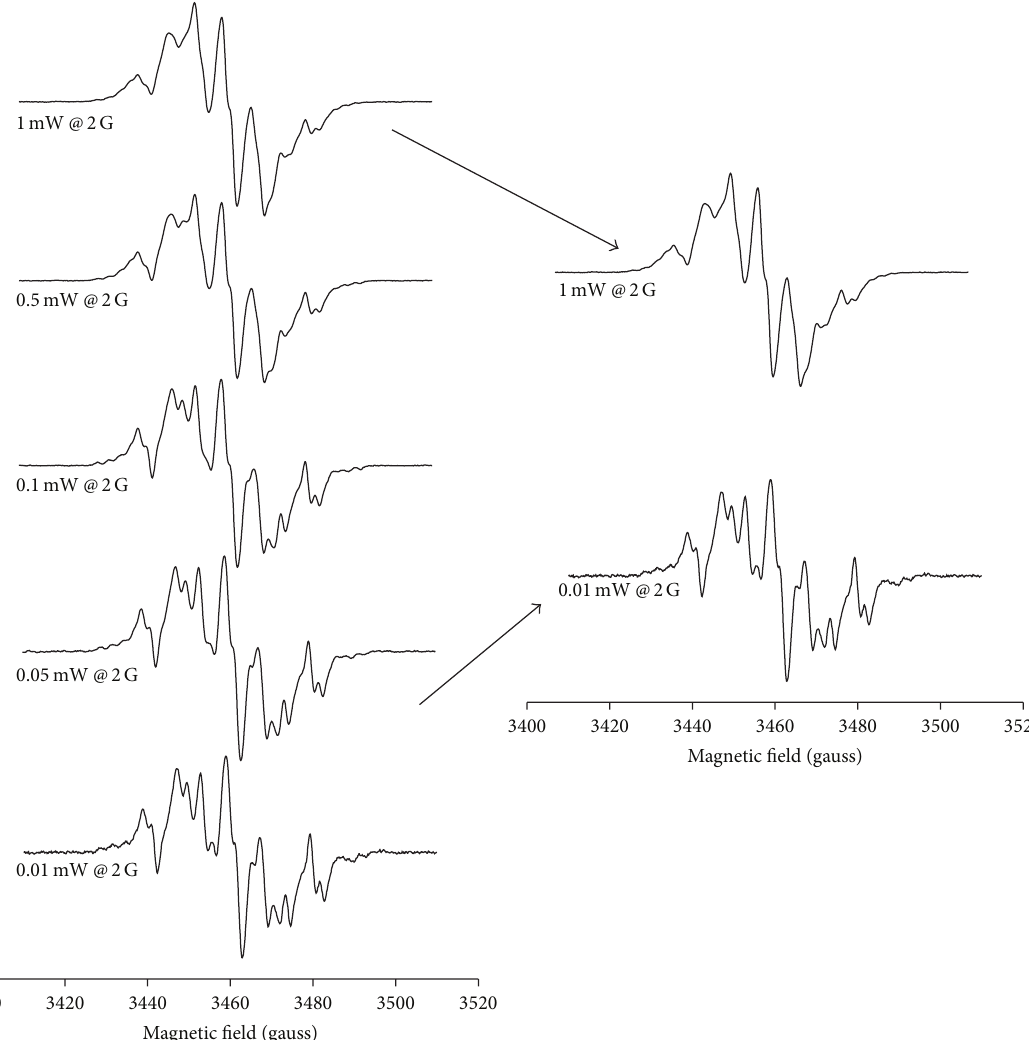
Figure 3: ESR microwave power saturation behavior of super hyperfine pattern ESR